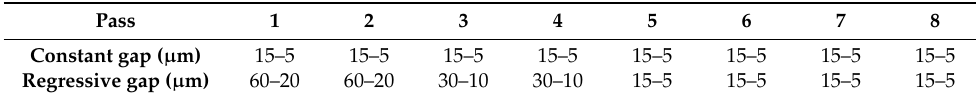
Table 1. Three-roll mill mixing modes